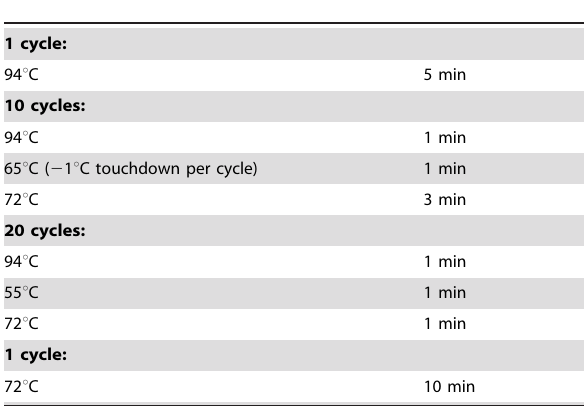
Table 3. Assay PCR